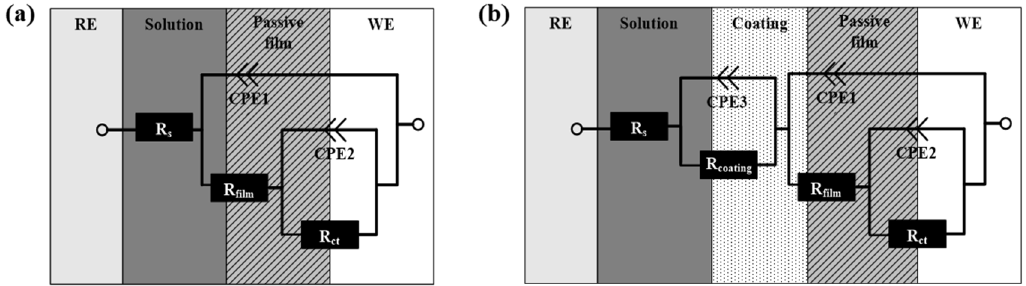
Figure 10. An equivalent circuit used to fit the results of the EIS tests: ( a ) one-time constant circuit, ( b ) two-time constant circuit.